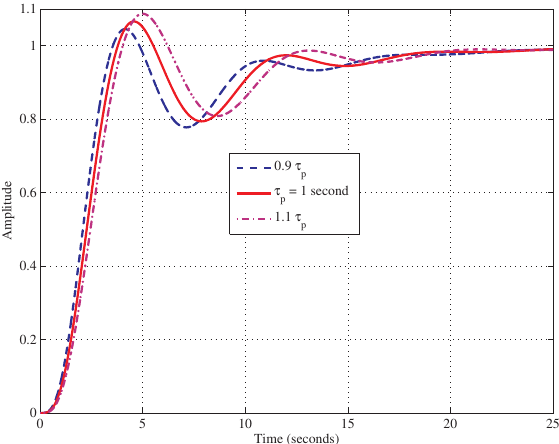
Figure 10. Unit step response in the first example for different plant time